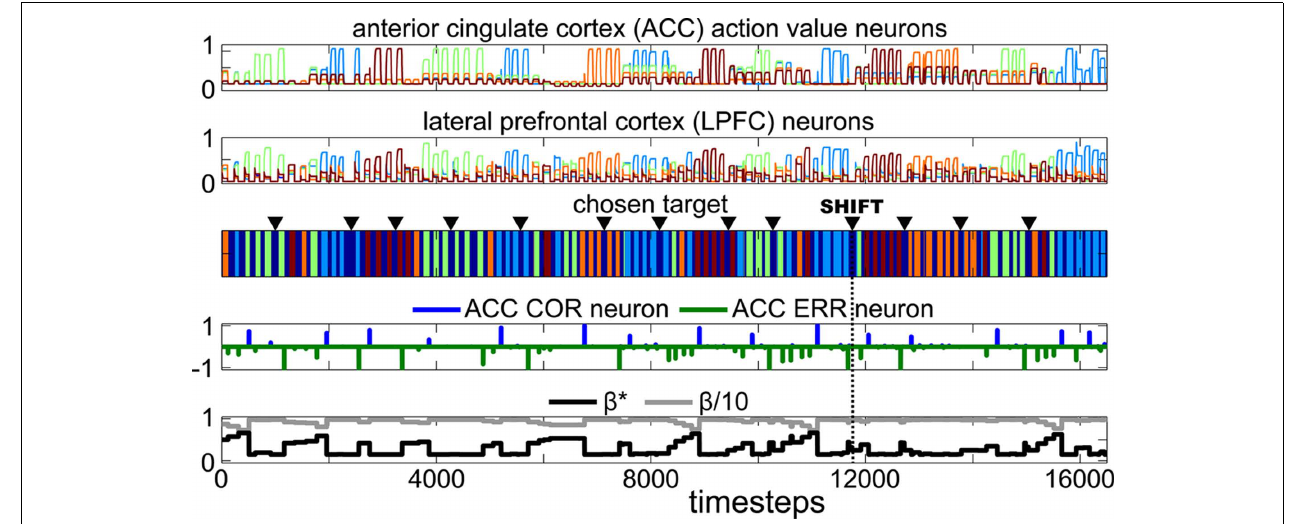
the robot learned to associate it with a condition change.This happened around time step 12000 (labeled as “SHIFT”) where the apparition of the wooden board successfully triggered a reset of action values and of the exploration